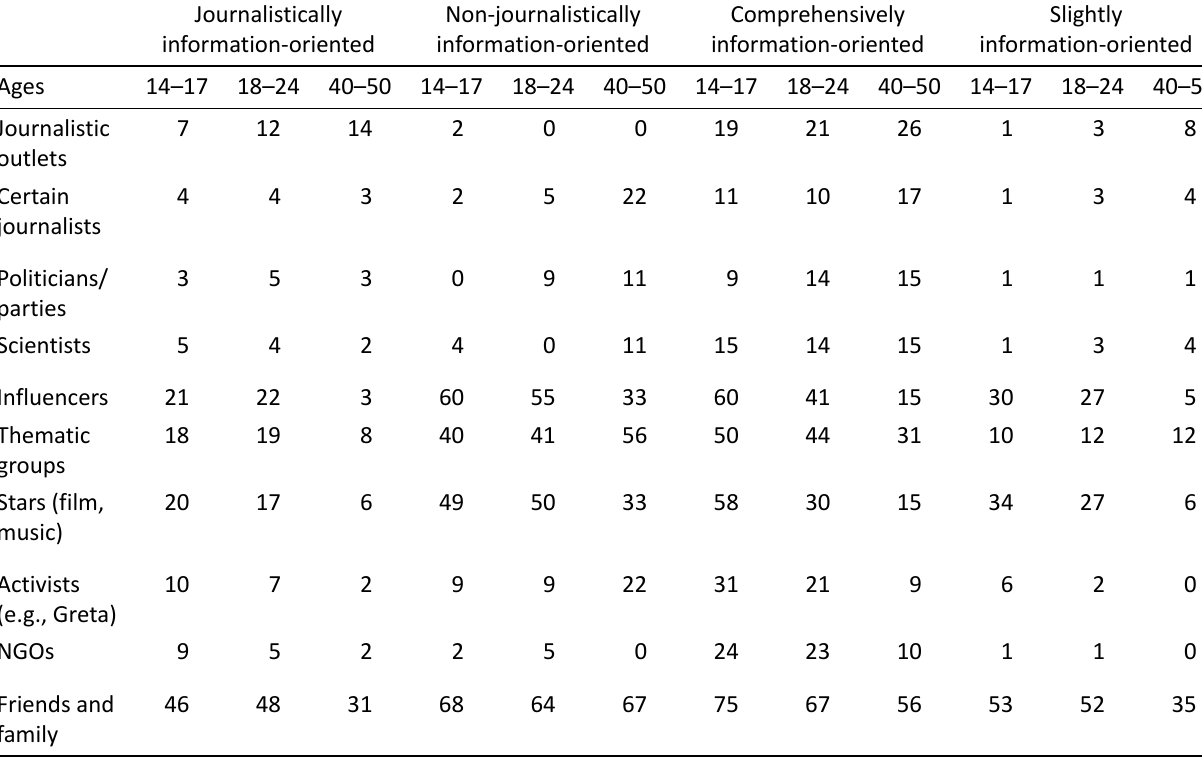
Table 2. Sources that are followed or subscribed to on social media platforms by type of information orientation, in %. Journalistically